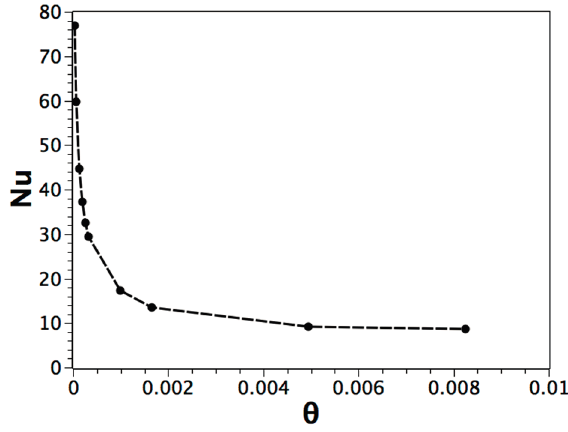
Figure 11. Nu versus dimensionless time (see Figure 1a) for Pr 50 = and 5 Ra 10 = .